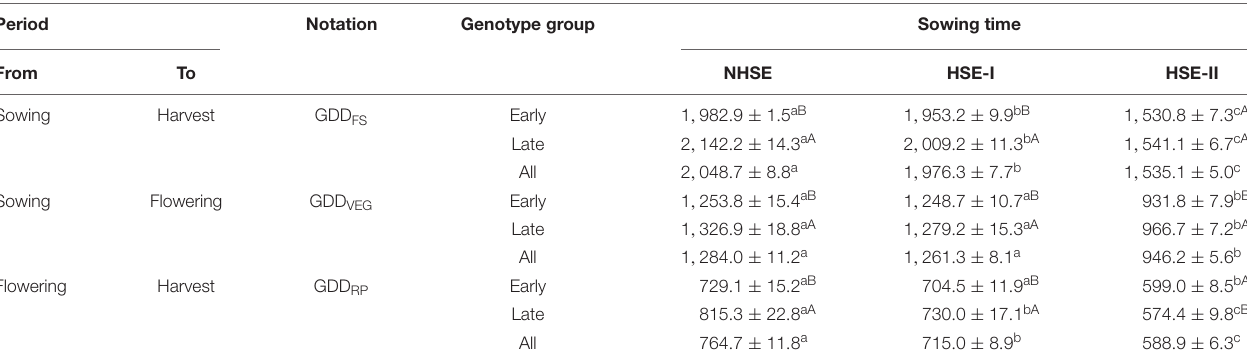
FIGURE 2 | Exposure of field pea genotypes to maximum temperature ( T MAX ) during 50% flowering ( ◦ C) and average ambient temperature during reproductive period ( ◦ C) under timely sown and late-sown conditions. The error bars represent ± standard error of means. NHSE, normal sowing time; HSE-I, 15 days after NHSE; HSE-II, 30 days after NHSE. Different lowercase letters (a–c) represent significant different within the row values ( p < 0.05). Different uppercase letters (A, B) represent significant difference within the column values (early and late genotypes) ( p < 0.05). TABLE 1 | Crop stage-wise growing degree days ( ◦ C) under different growing